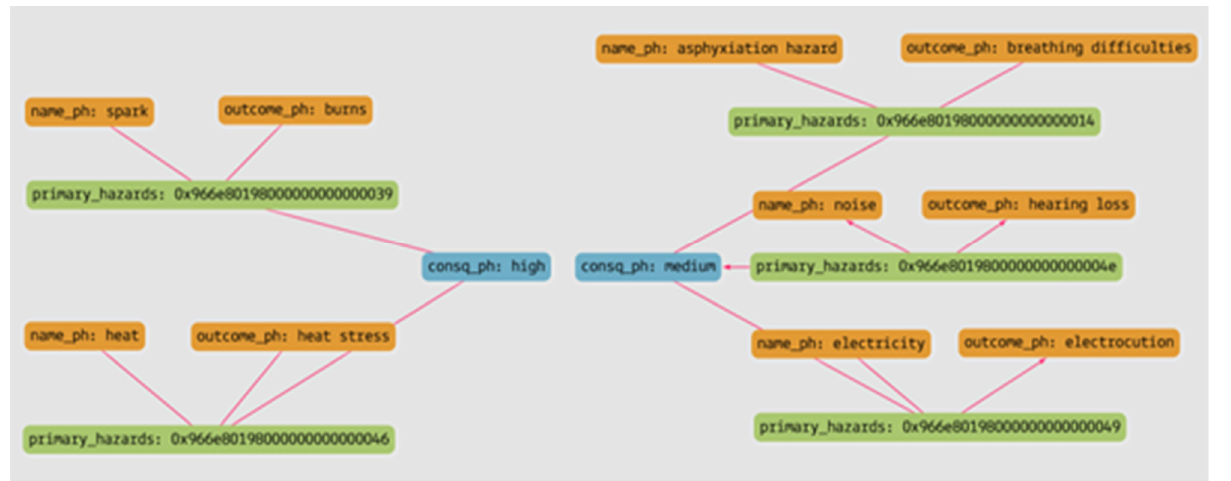
Figure 10. The result of Query 1, in a graph form. Table 5. The result of Query 1, in a tabular form.